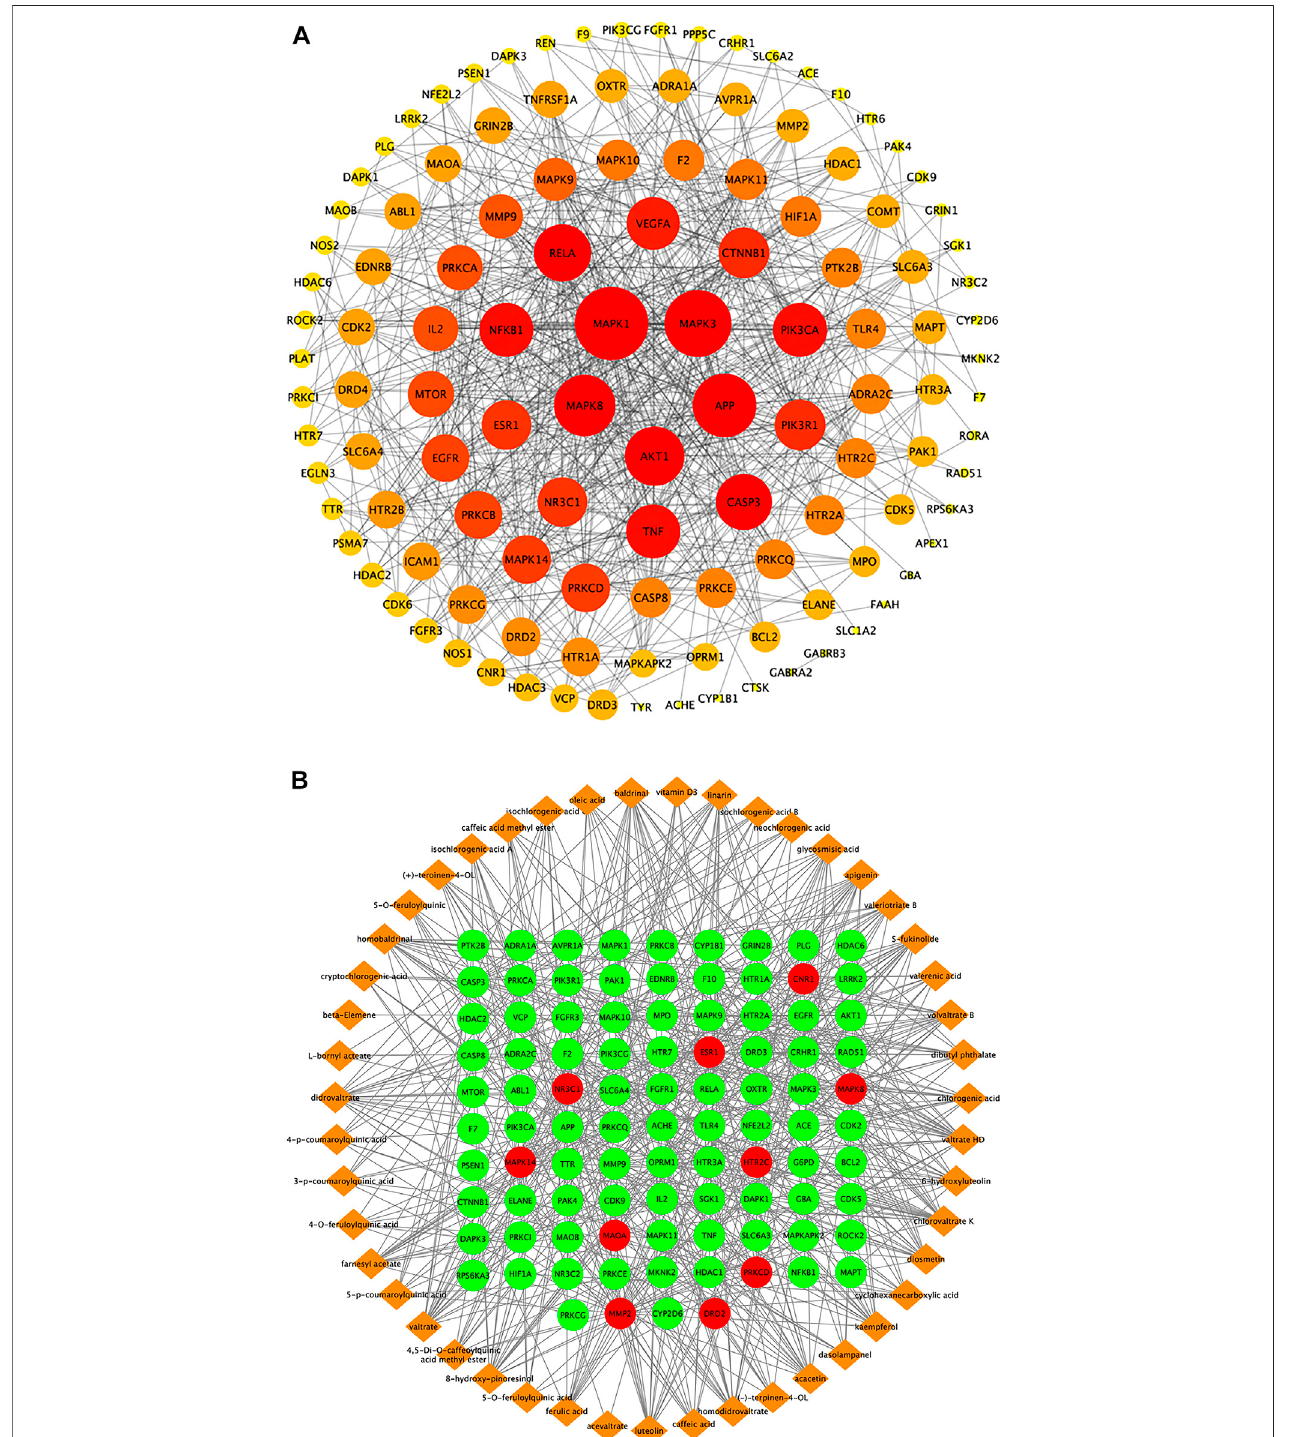
FIGURE 5 | Target proteins interaction network, ingredient-target network, and compound – target – pathway network of potential targets for primary active ingredients from ZZX against PTSD. (A) Interaction network of ZZX target proteins involved in PTSD; (B) ZZX active ingredient – target network associated with PTSD.